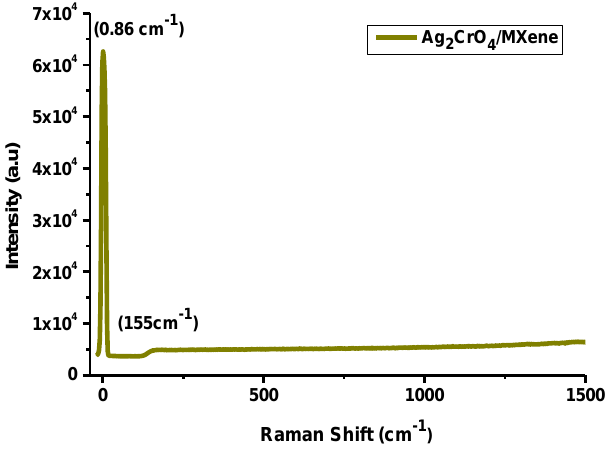
Figure 5. Raman spectra of MXene/Ag 2 CrO 4 nanocomposite.